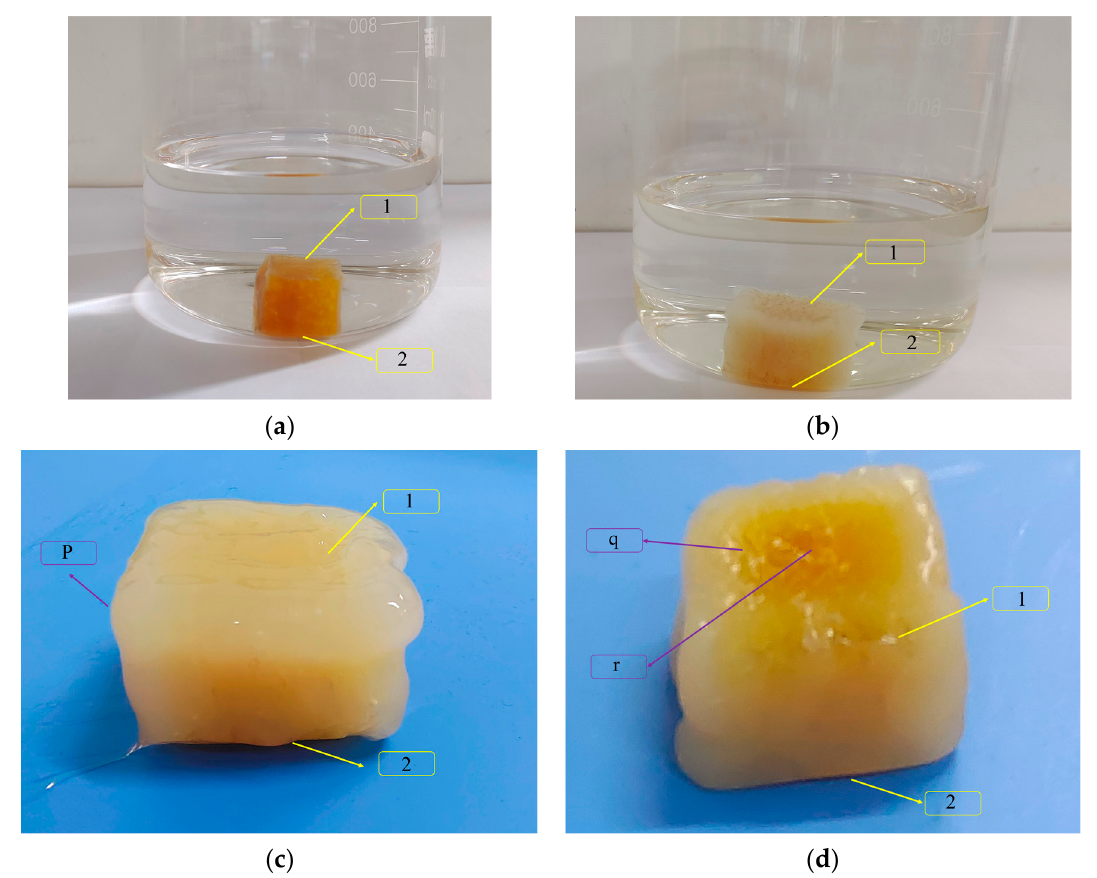
Figure 14. Soak NR in S-150. ( a ) Cube rubber block bubble in the case of S-150, volume 1.5 × 1.5 × 1.5 cm 3 ; ( b ) The rubber block has a volume of 1.8 × 2 × 2 cm 3 in S-150 for 4 h; ( c ) When the rubber block was removed from S-150 for 12 h, the volume was 2 × 2.5 × 2.5 cm 3 ; ( d ) Rubber block reversed. Here 1 was the top area of the rubber and 2 was the bottom area of the rubber; p, q and r were the liquid rubber, solid-liquid blending rubber and original rubber respectively.